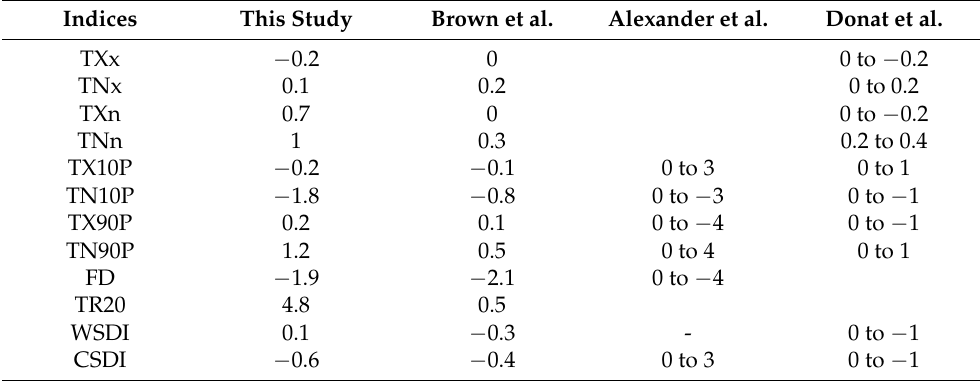
Table 3. Decadal trends in extreme temperature indices from Fall et al. (2021), Brown et al. (2010), Alexander et al. (2006), and Donat et al. (2013). Study periods are 1978–2017, 1951–2005, 1951–2003, and 1951–2010, respectively. Indices This Study Brown et al. Alexander et al. Donat et al. TXx − 0.2 0 0 to − 0.2 TNx 0.1 0.2 0 to 0.2 0.7 0 0 to −